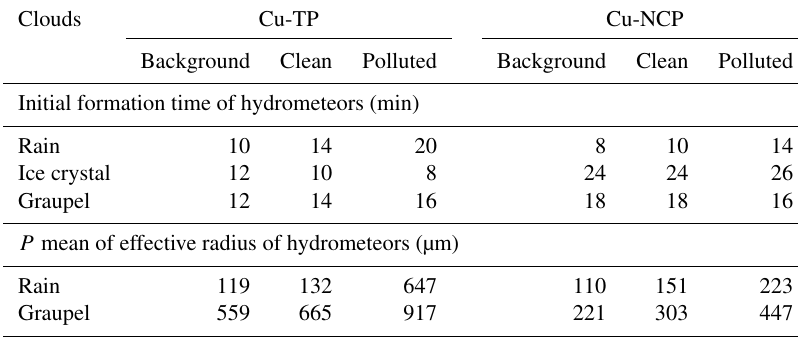
Table 1. Response of cloud properties in Cu-TP and Cu-NCP under three aerosol conditions ∗ . Clouds Cu-TP Cu-NCP Background Clean Polluted Background Clean Polluted Initial formation time of hydrometeors (min) Rain 10 Ice crystal